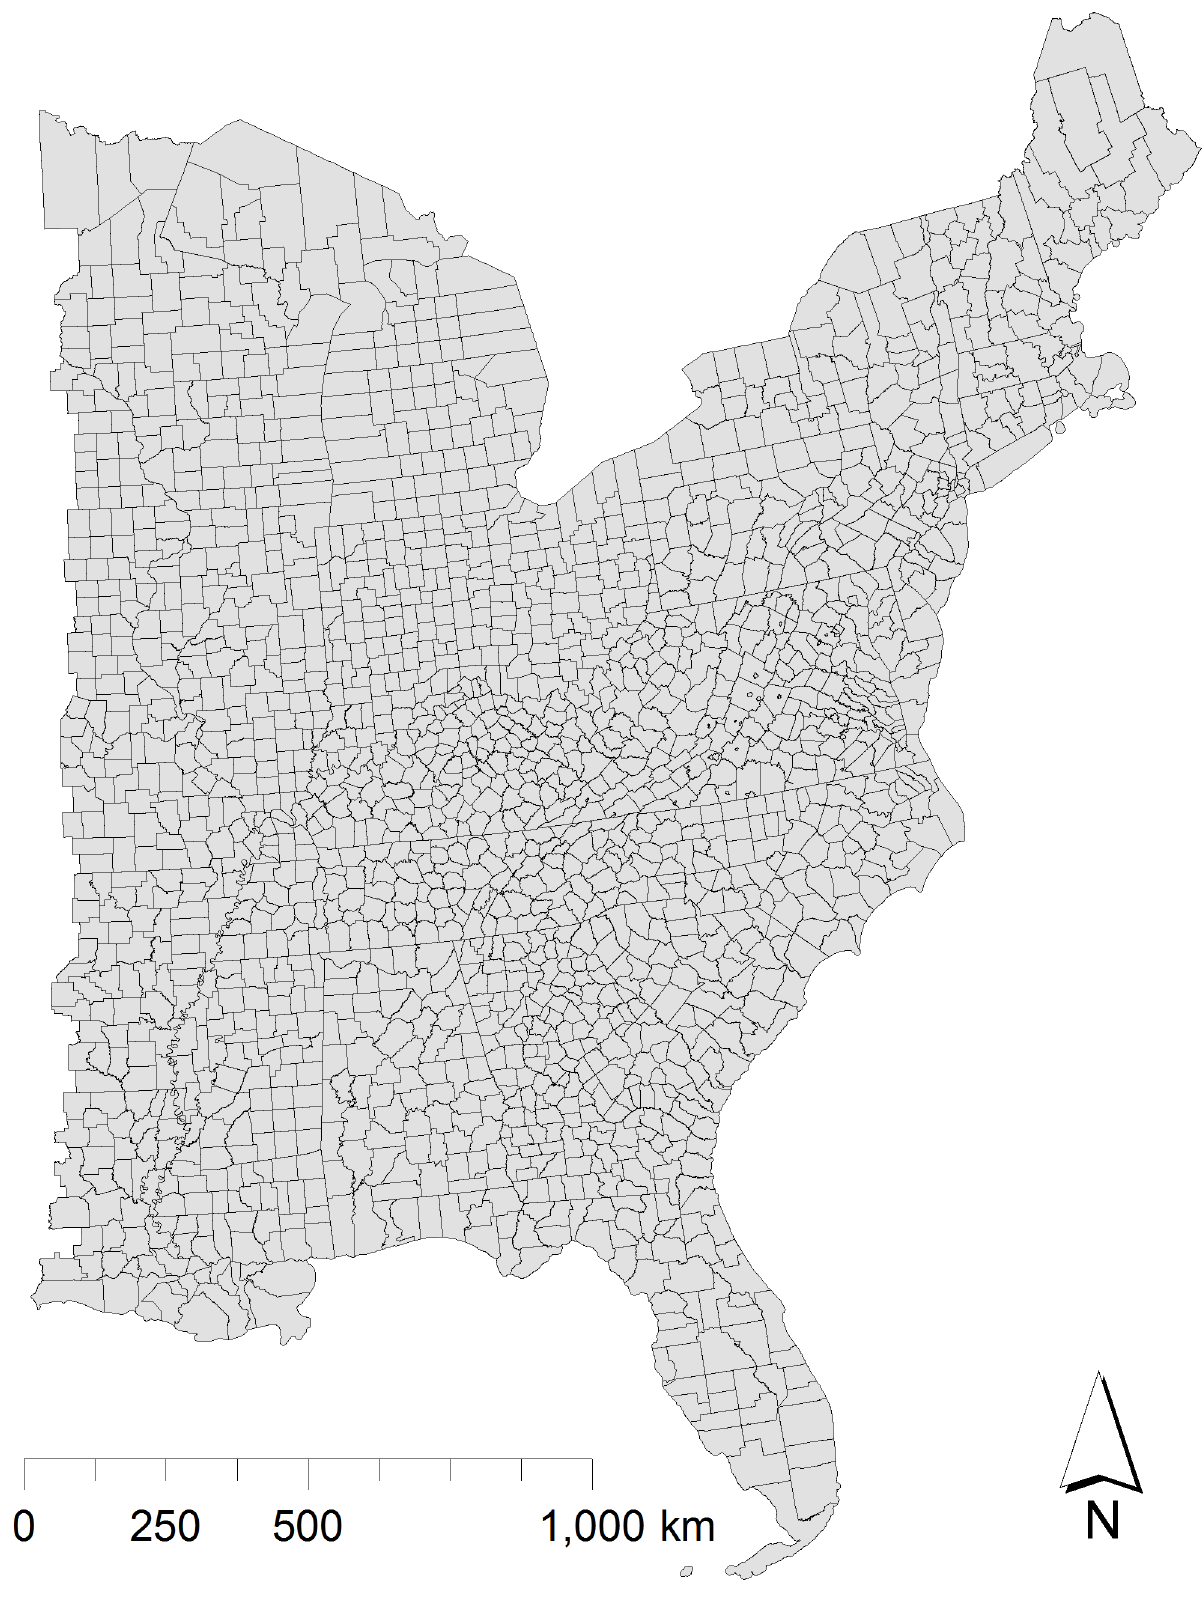
Figure 1. Spatial extent of Eastern United States considered in the analysis, based on 2000 U.S. Census (24.3 6 N to 45.9 6 N latitude, 93.0 6 W to 66.5 6 W longitude).